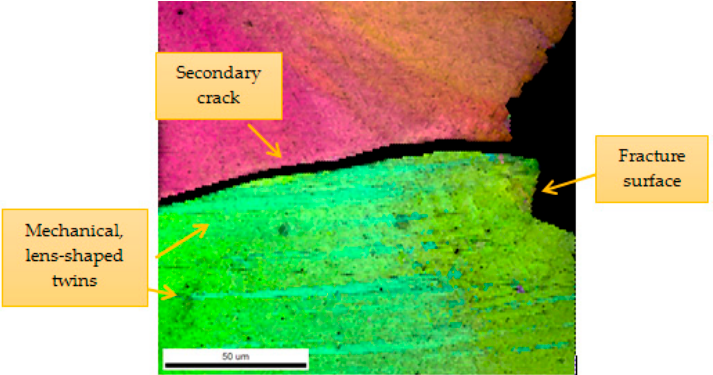
Figure 8. Mechanical twins developed on the fracture surface of β -phase grains after Charpy impact test; CuZn42 alloy sample in heat treated condition, section transverse to fracture surface. Combined image quality and IPF map. Unit: µ